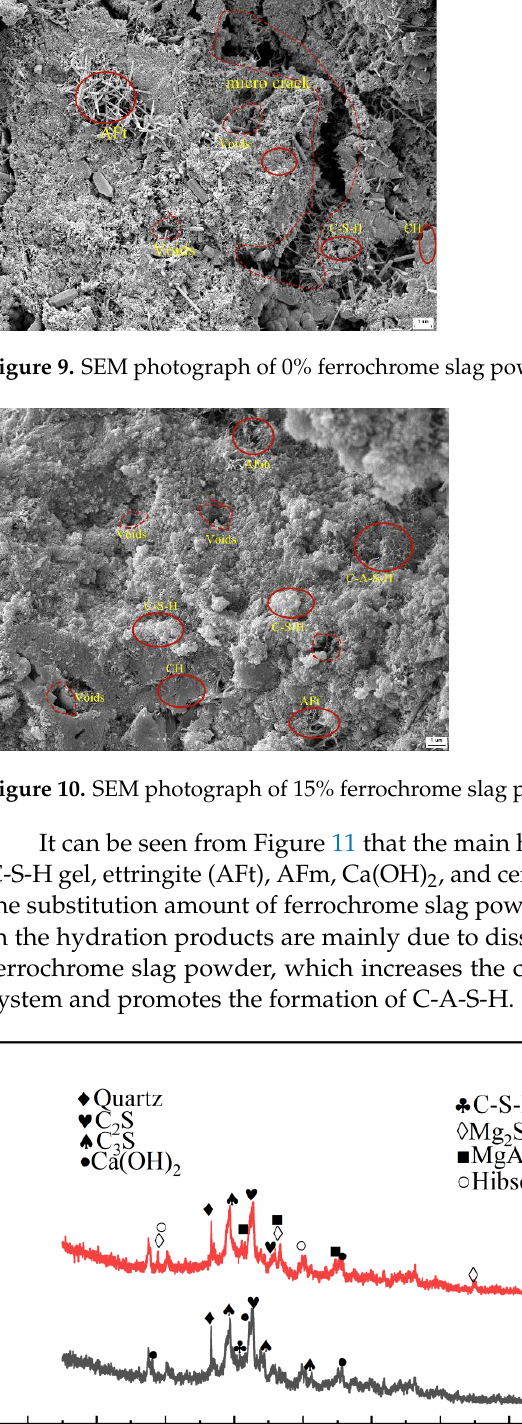
Figure 11. XRD of ferrochrome slag cement mortar. C-A-S-H formed by the hydration reaction reduces the content of AlO 2 − and Ca 2+ in the system, which promotes the hydration reaction between the active components in the ferrochrome slag powder and Ca(OH) 2 to generate C-S-H and C-A-S-H gels. At the same time, the decrease in Ca 2+ concentration in the system also promotes the full reaction of C 2 S/C 3 S without hydration to produce more C-S-H gels, filling the gaps between the